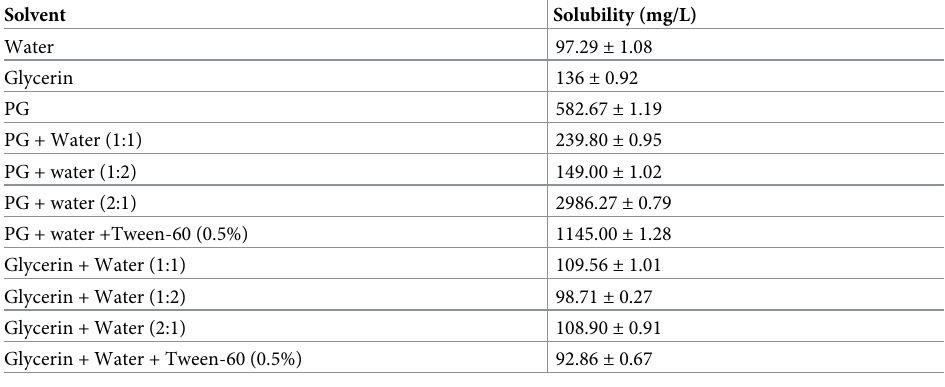
Table 3. Solubility of clopidogrel in different nonvolatile solvent and their mixture.